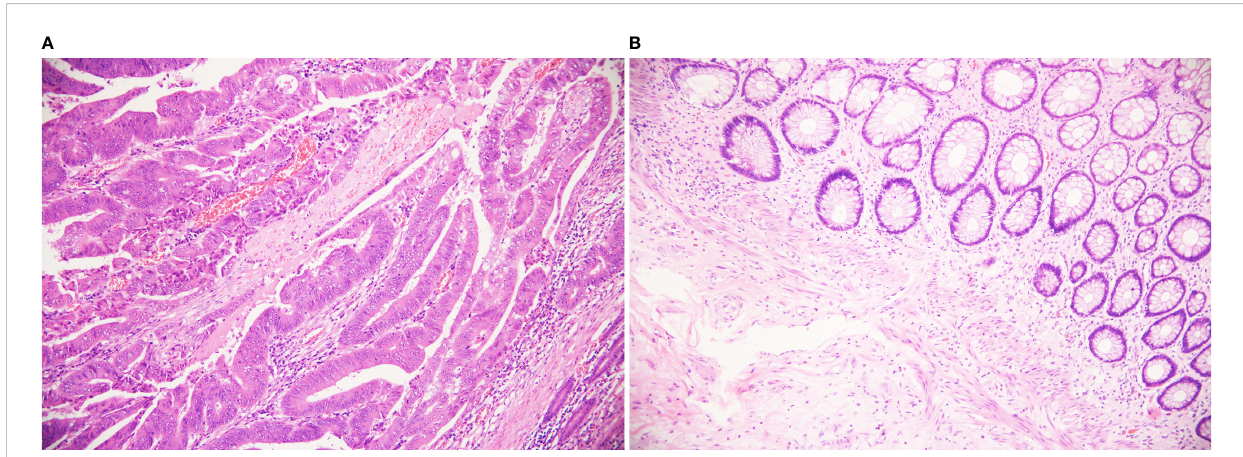
FIGURE 3 Different pathological fi ndings after TRACE treatment. (HE staining, 200×) (A) It shows poor response to tumors, in which still a lot of residual tumor cells. Arrows show tumor cells. (B) It shows pCR complete remission without residual tumor